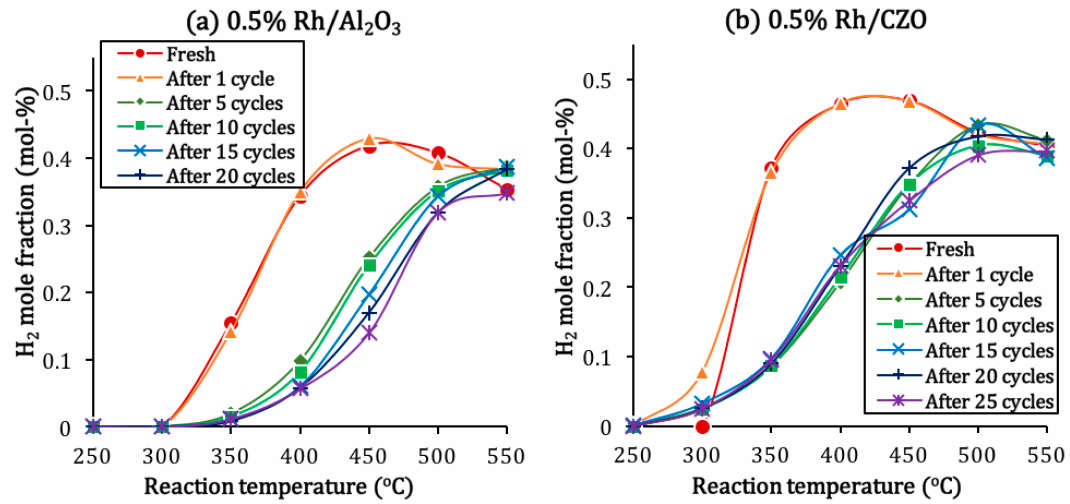
Figure 9. Activity of regenerated ( a ) 0.5% Rh/Al 2 O 3 and ( b ) 0.5% Rh/CZO catalysts after 1, 5, 10, 15, 20, and 25 cycles in the aging-regeneration cycle tests. After every five cycles of aging/regeneration. The catalyst activity is plotted in terms of H 2 product mole fraction as a function of SR temperature from 250 °C to 550